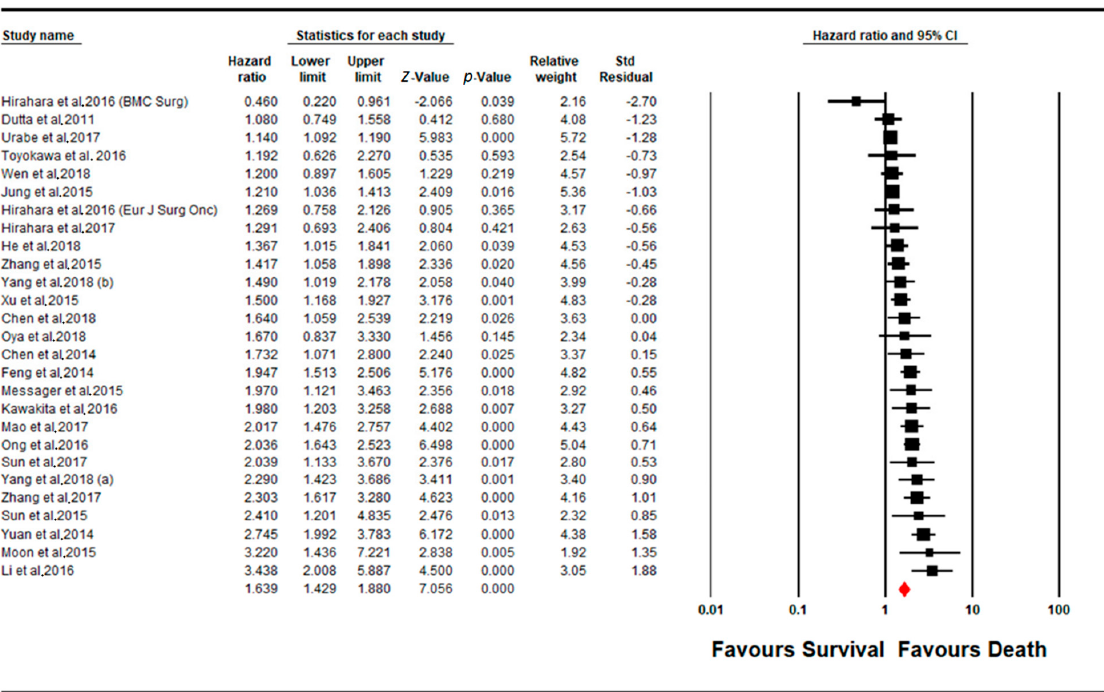
Figure 3. Forest plot of NLR subgroup.